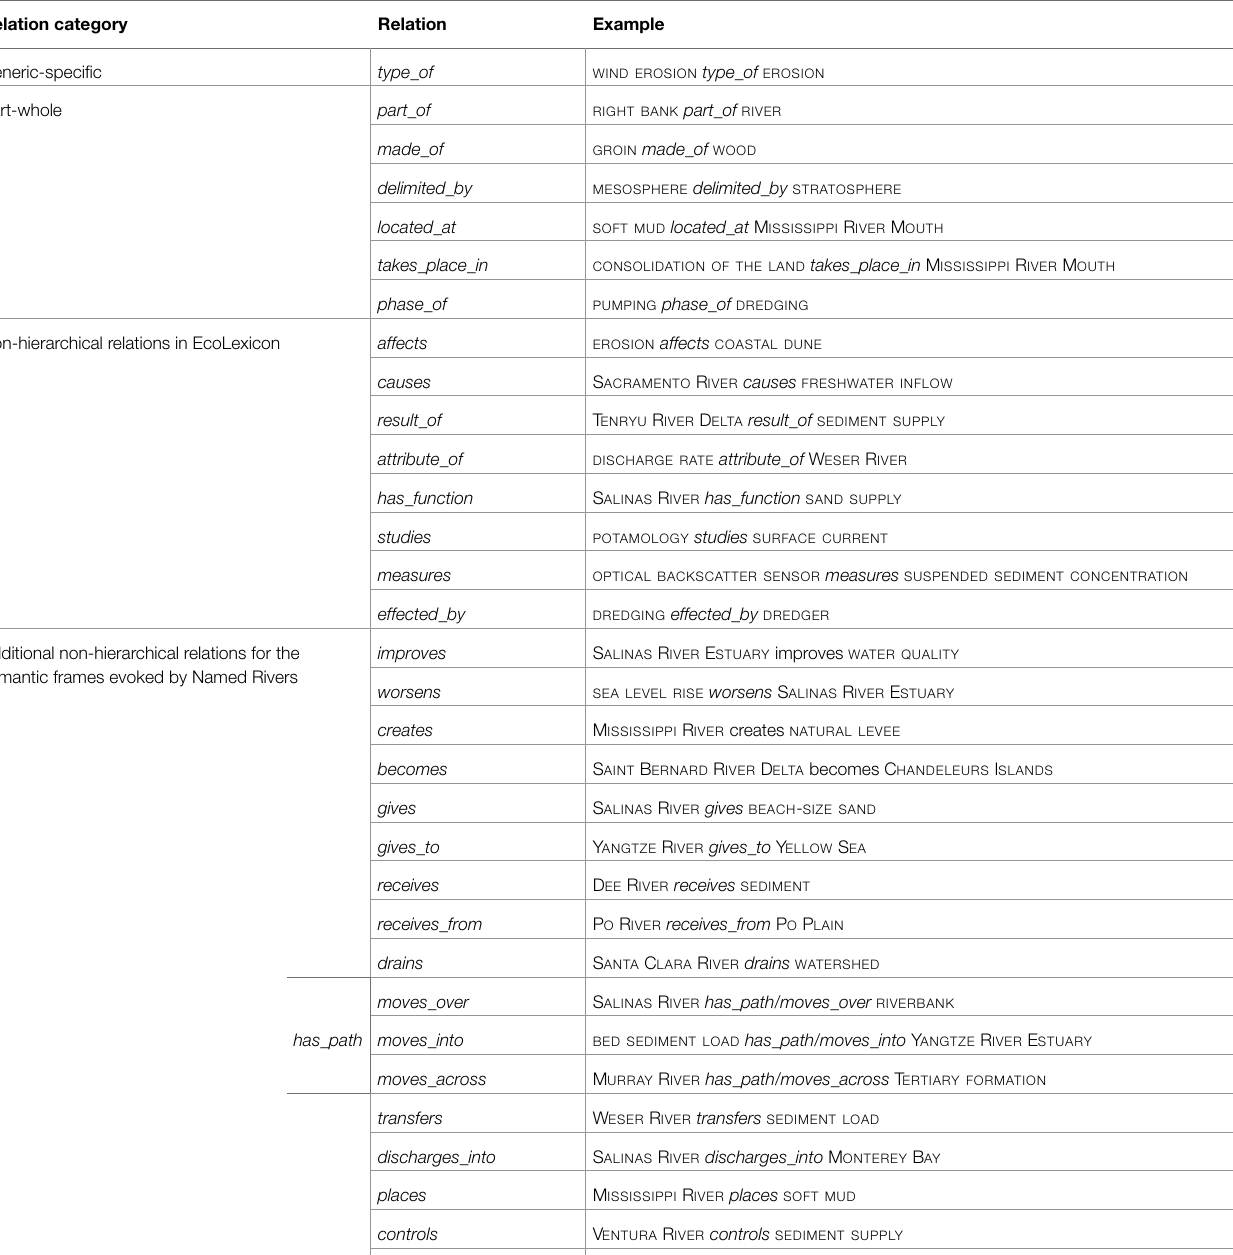
TABLE 3 | Semantic relations used during the annotation